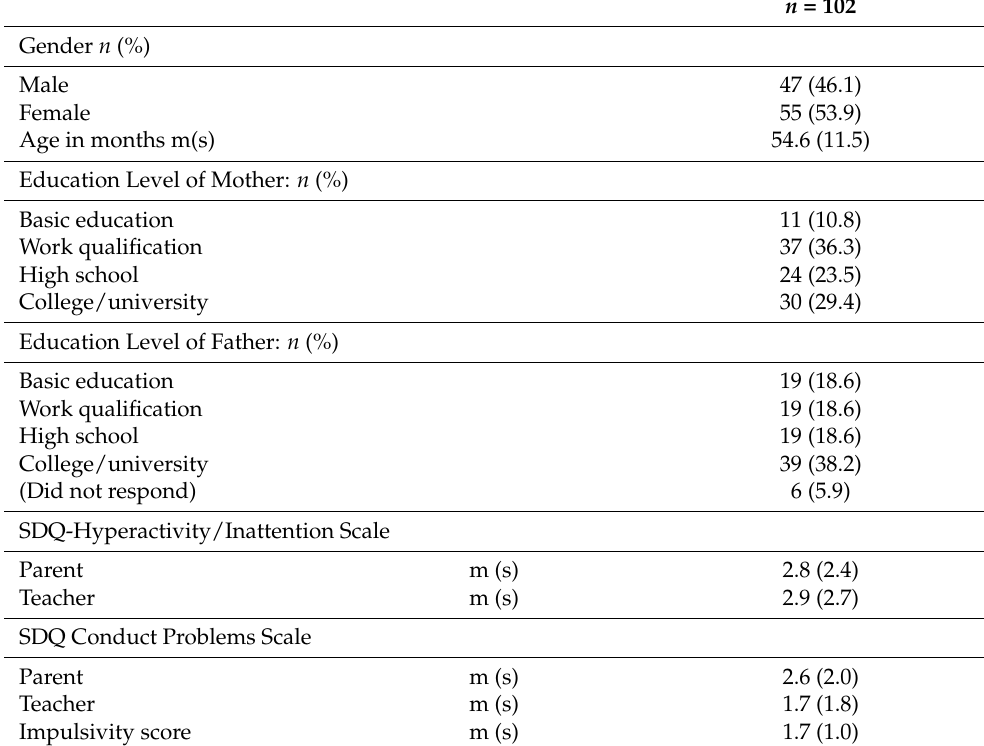
Table 1. Descriptive statistics for Study